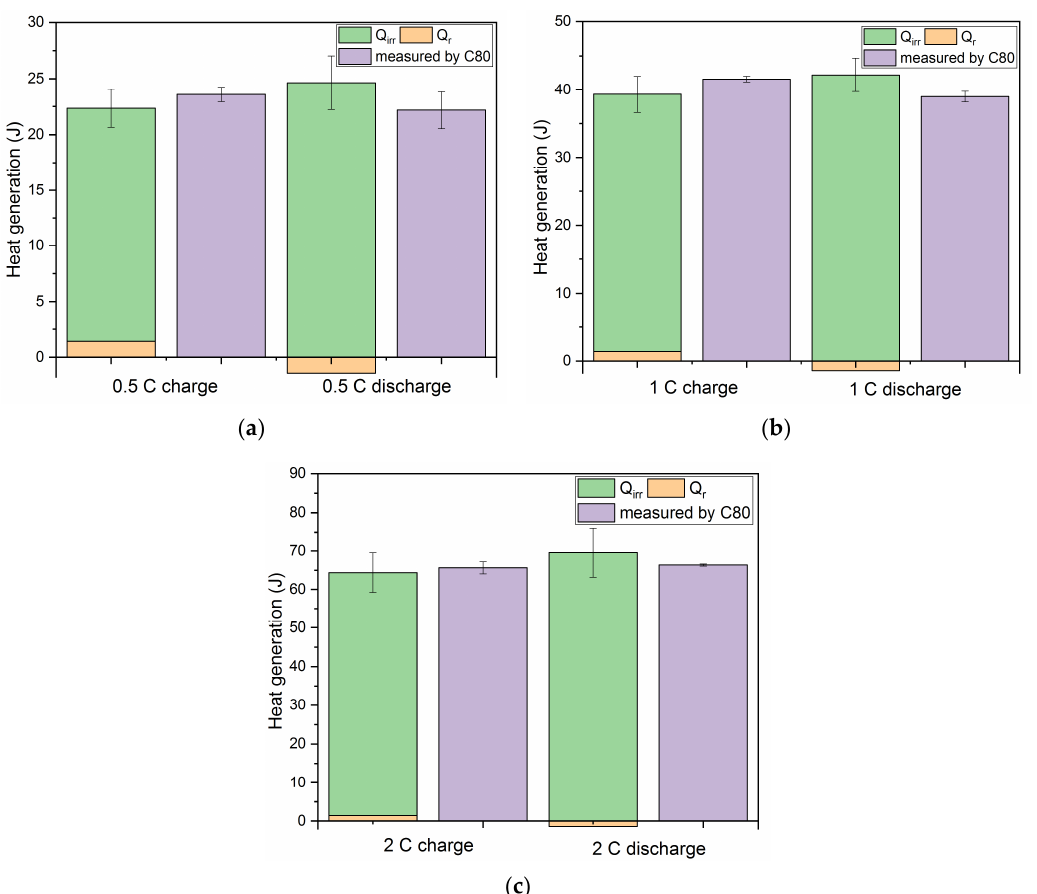
Figure 9. Comparison of calculated heat flow rates versus SOC/DOD under different C-rates and heat flow rates measured by C80 calorimeter: ( a ) charging with 0.5 C; ( b ) discharging with 0.5 C; ( c ) charging with 1 C; ( d ) discharging with 1 C; ( e ) charging with 2 C; ( f ) discharging with 2 C. The total amount of the generated heat measured in the calorimeter (C80) compared to the contribution of the irreversible Q irr and the reversible part Q r is shown in Figure 10. At the highest C rate, the deviations of the calculated from the measured results for charging and discharging process, respectively, are both reaching minimum values. The deviation for all C-rates falls into the range of +/− 5%.